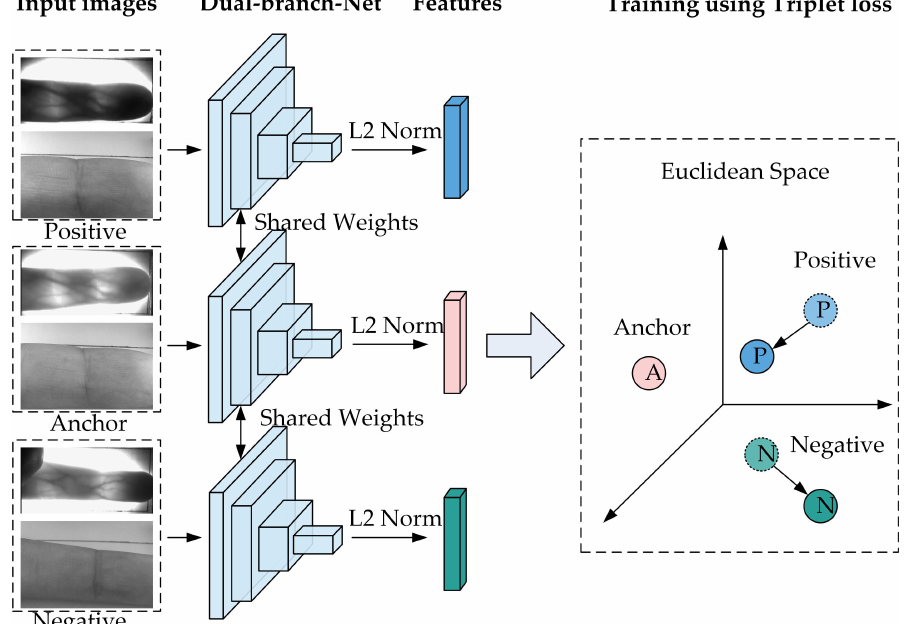
Figure 4. Training a network using triplet loss